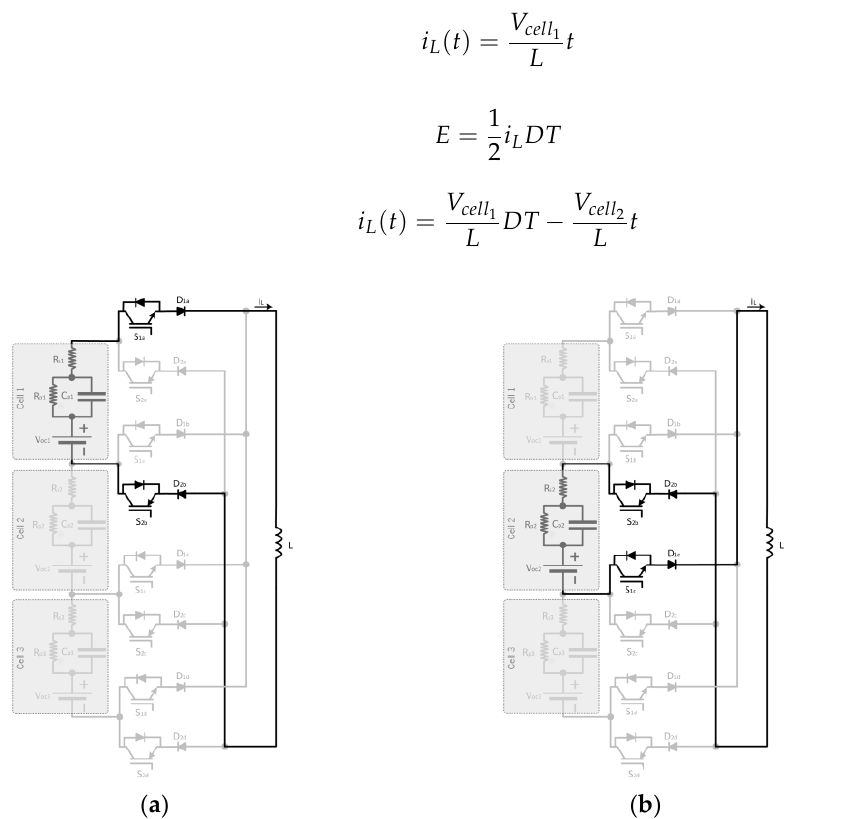
Figure 10. Operating modes of the SI converter: ( a ) first stage, T 1 ; ( b ) second stage, T 2 .